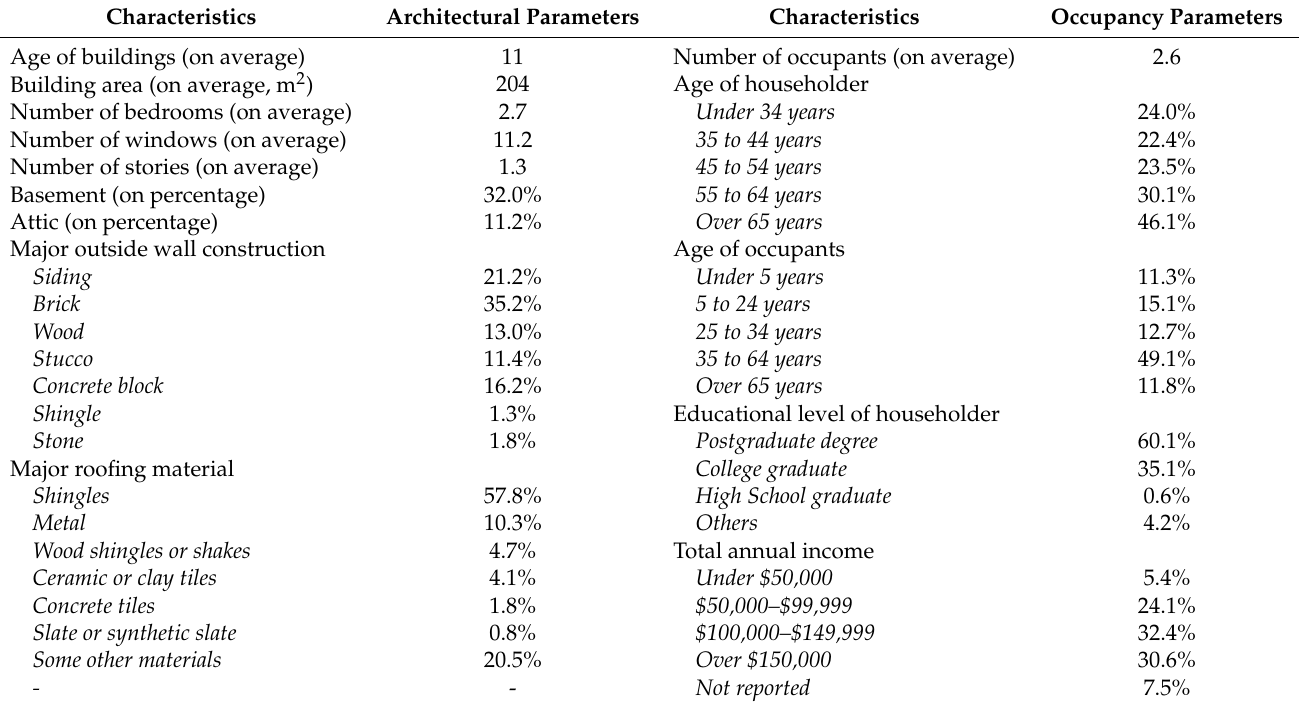
Table 1. The architectural, occupancy parameters in residential buildings